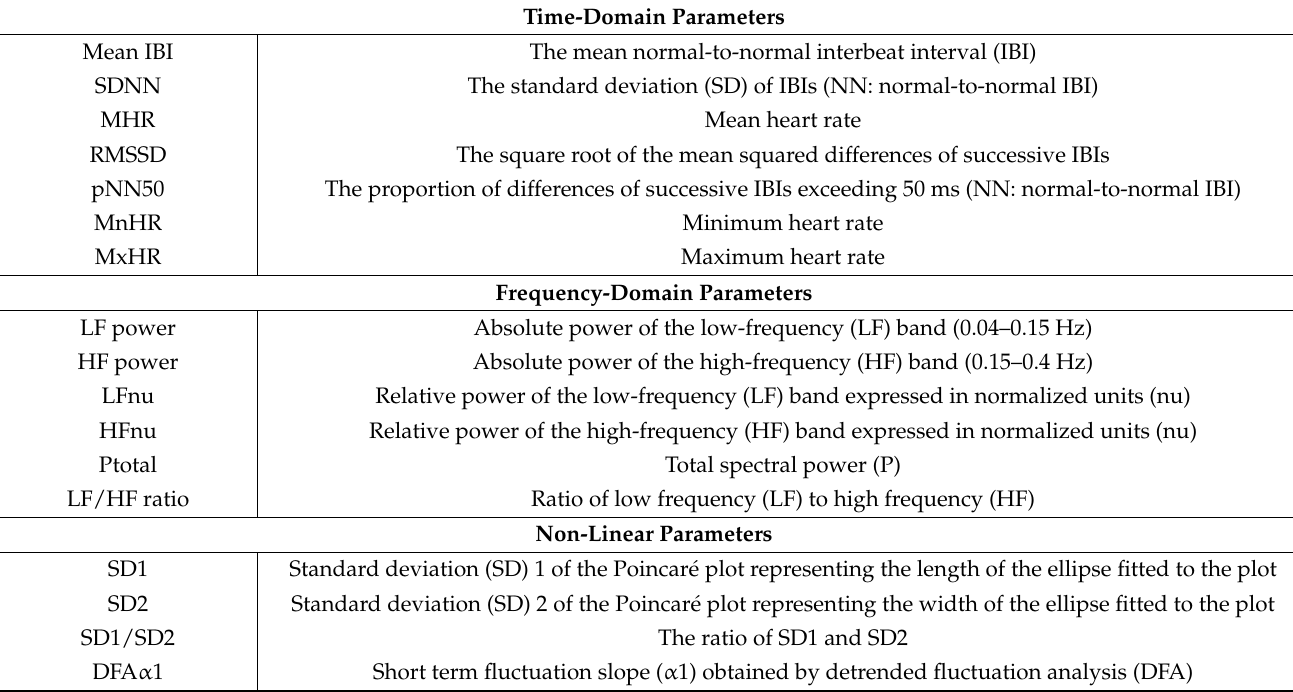
Table 1. Heart rate variability parameters analyzed in the study. Time-Domain